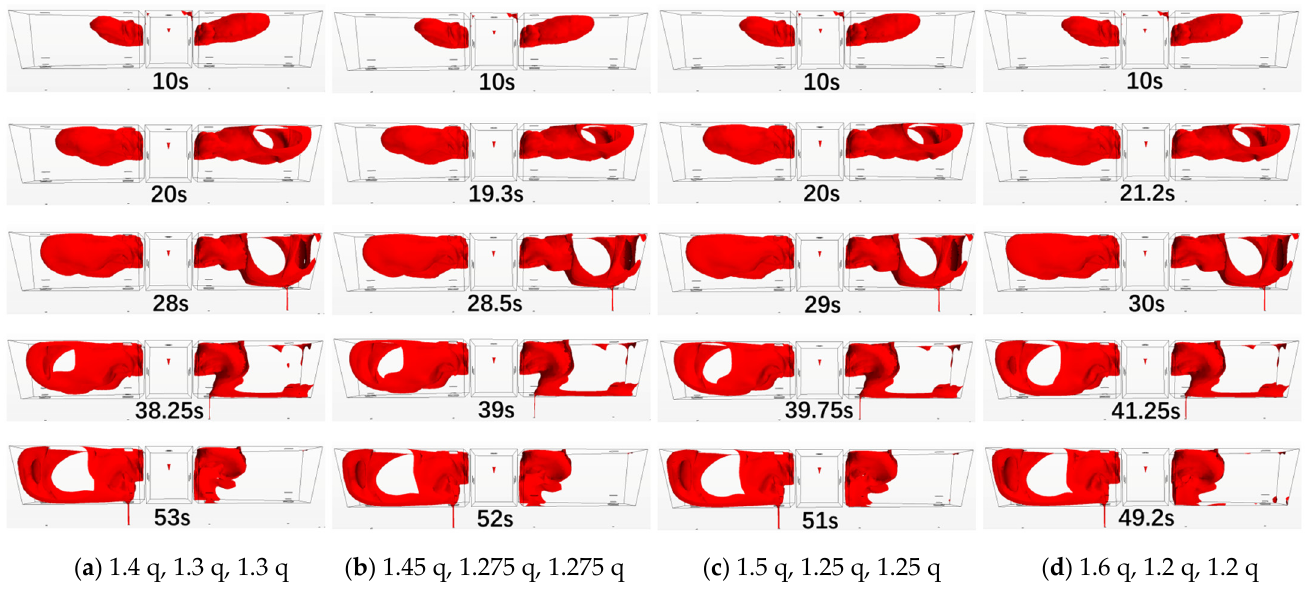
Figure 21. Isosurface evolution results of the double-weir tundish with non-uniform increasing casting flow rate under strand 1 blockage condition ( ω = 10 − 5 ).